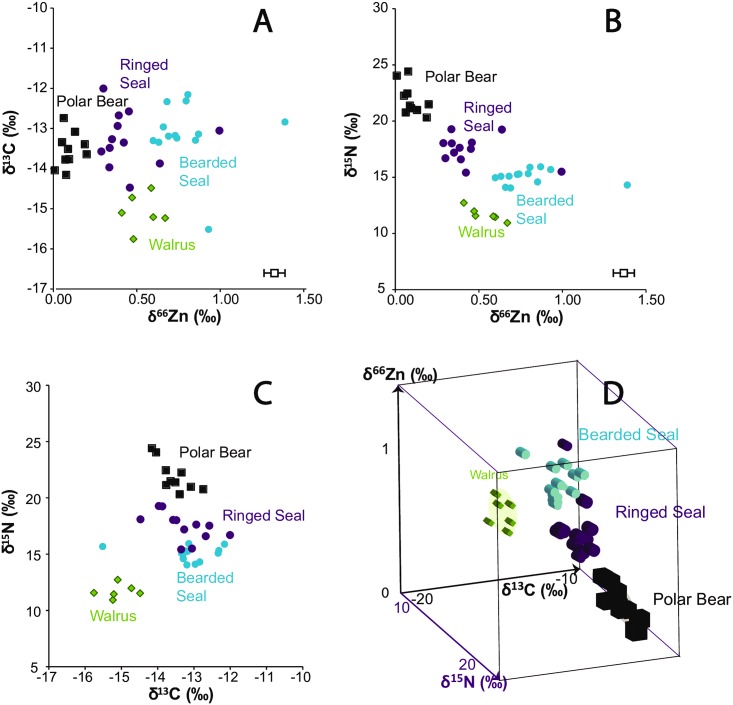
Cortical bone isotopic values of arctic mammals for C, N, and Zn.A) δ66Znbioapatite vs. δ13Ccollagen values for four species of marine mammals (B) δ66Znbioapatite vs. δ15Ncollagen values, (C) δ15Ncollage vs. δ13Ccollagen and (D) 3D plot showing that Zn, N and C isotopic compositions of marine mammals enables a distinguishing of the different species. Measurement uncertainties are given by the white boxes.